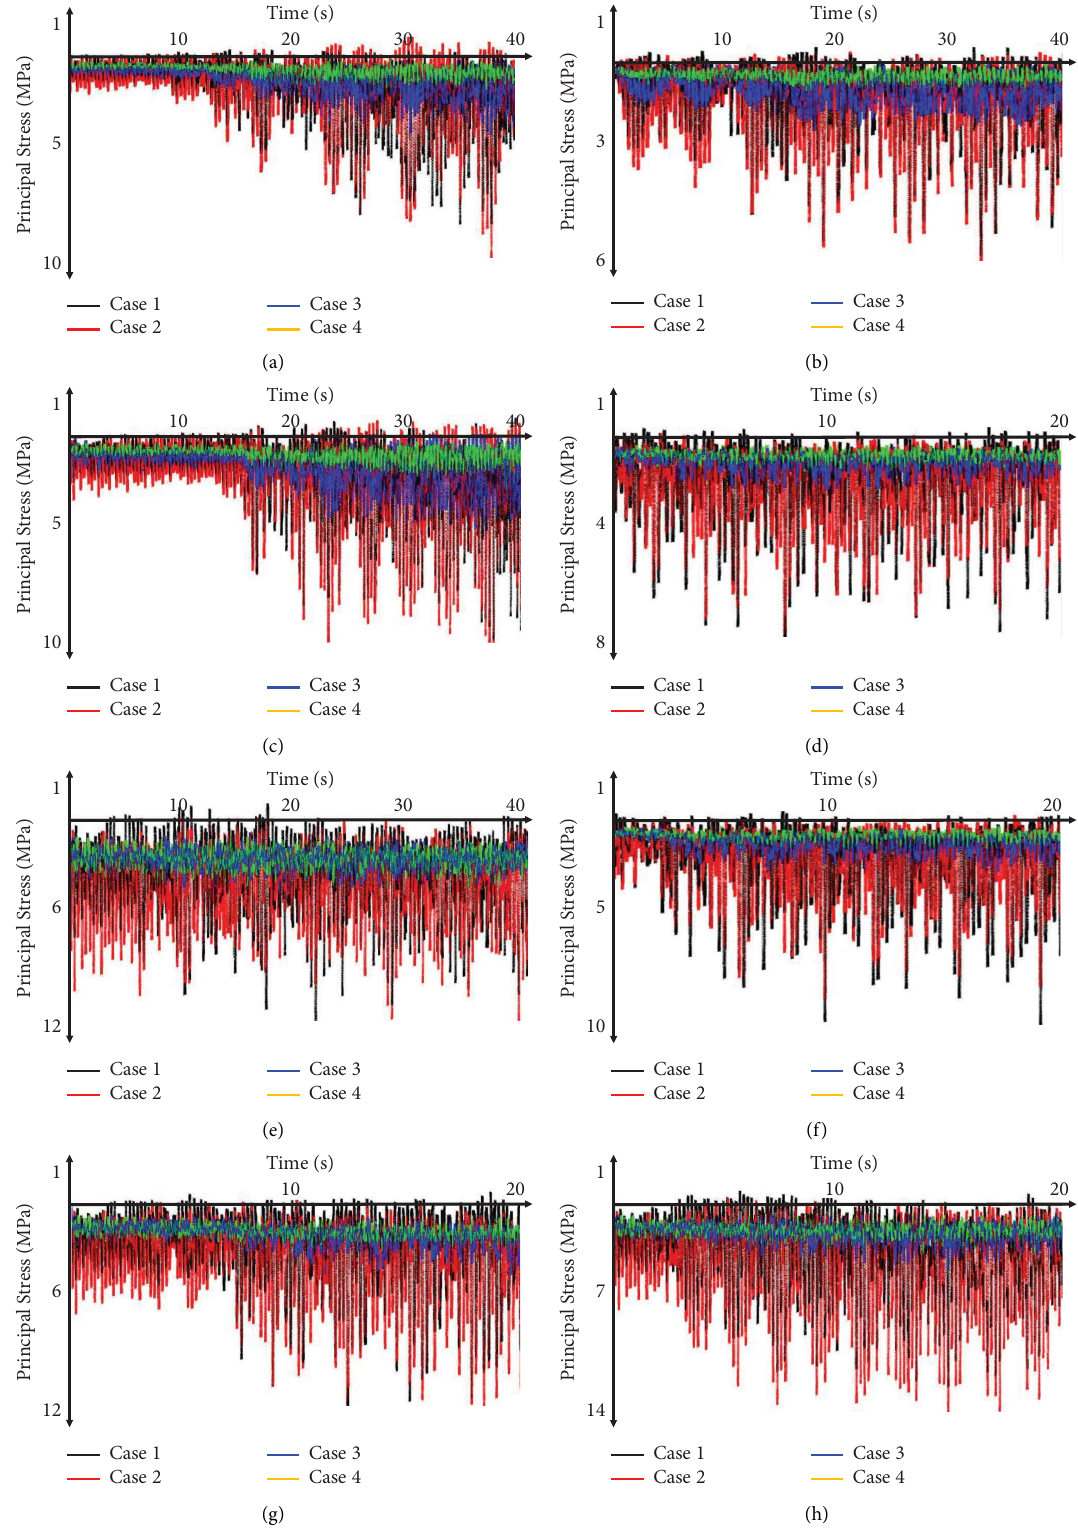
Figure 7: Earthquake PS results of Ermenek arch dam for EQ9–EQ16 earthquakes: (a) EQ9, (b) EQ10, (c) EQ11, (d) EQ12, (e) EQ13, (f) EQ14, (g) EQ15, and (h)